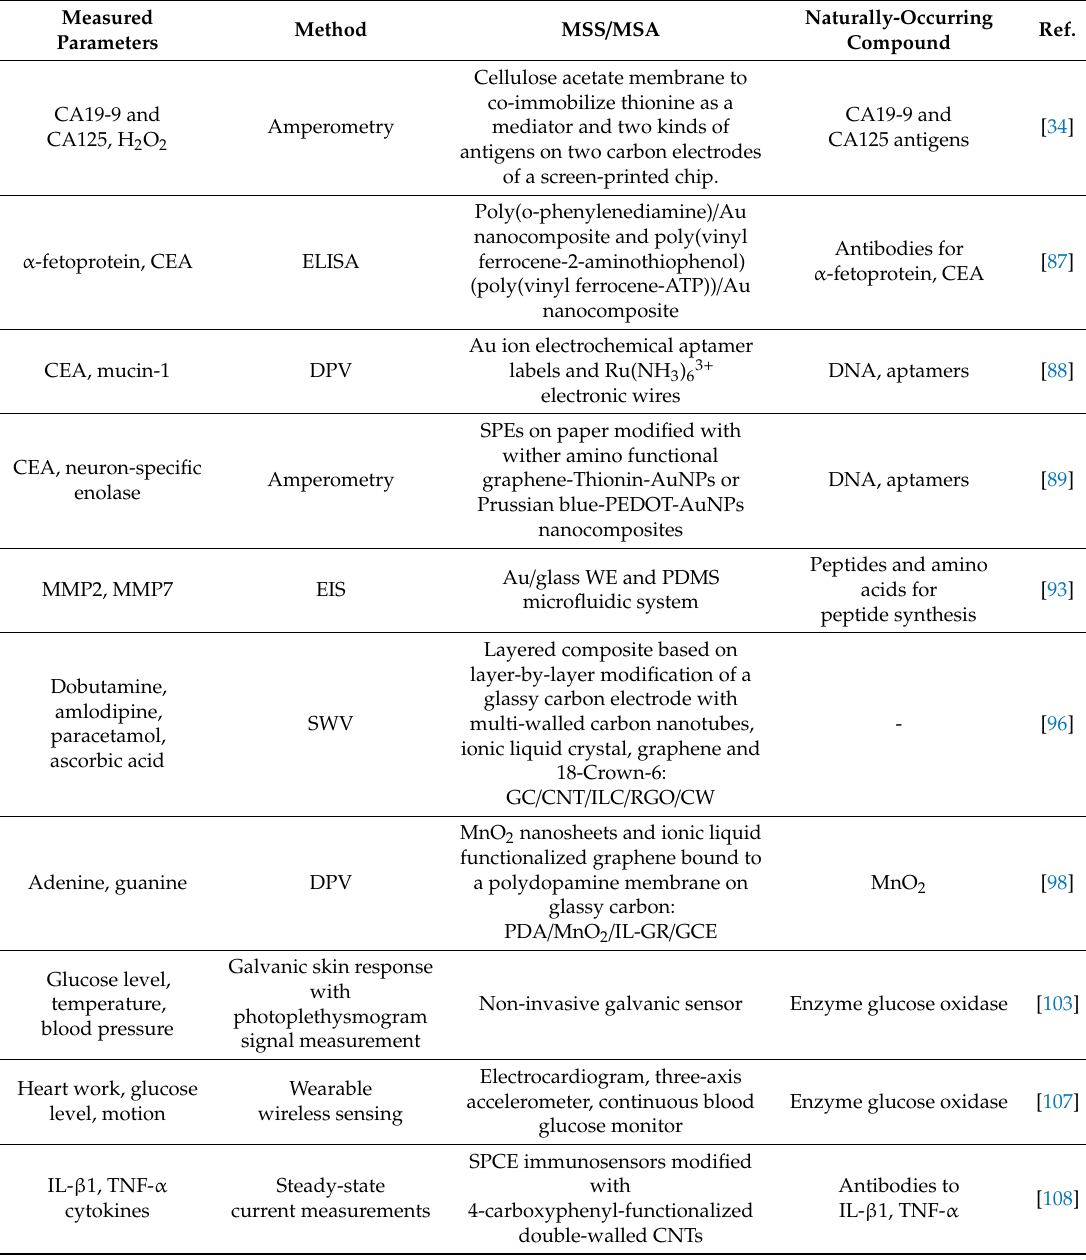
Table 1. Summary of MSS / MSA application for blood